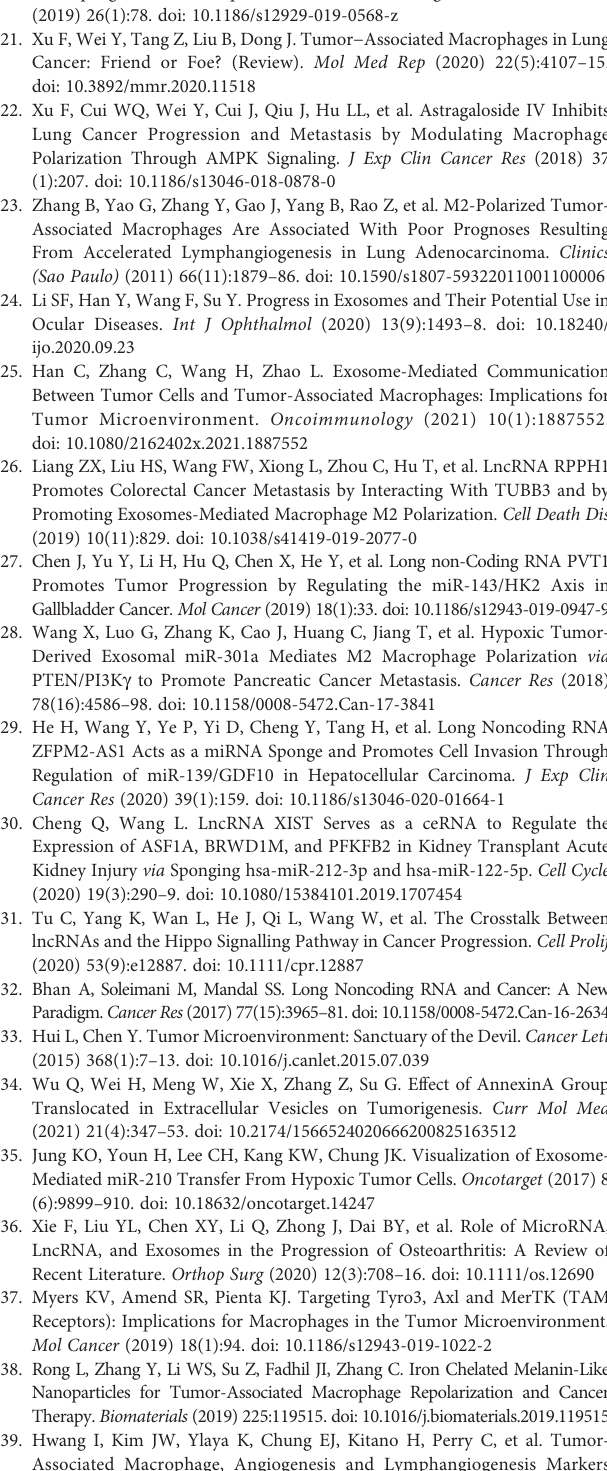
Supplementary Figure 4 | ELFN1-AS1 promoted macrophage M2 polarization via regulating the miR-663b/CREB1